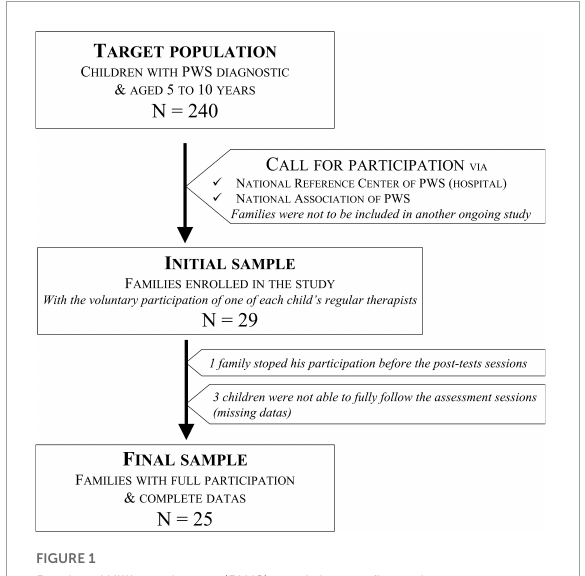
FIGURE1 Prader – Willi syndrome (PWS) participants flow